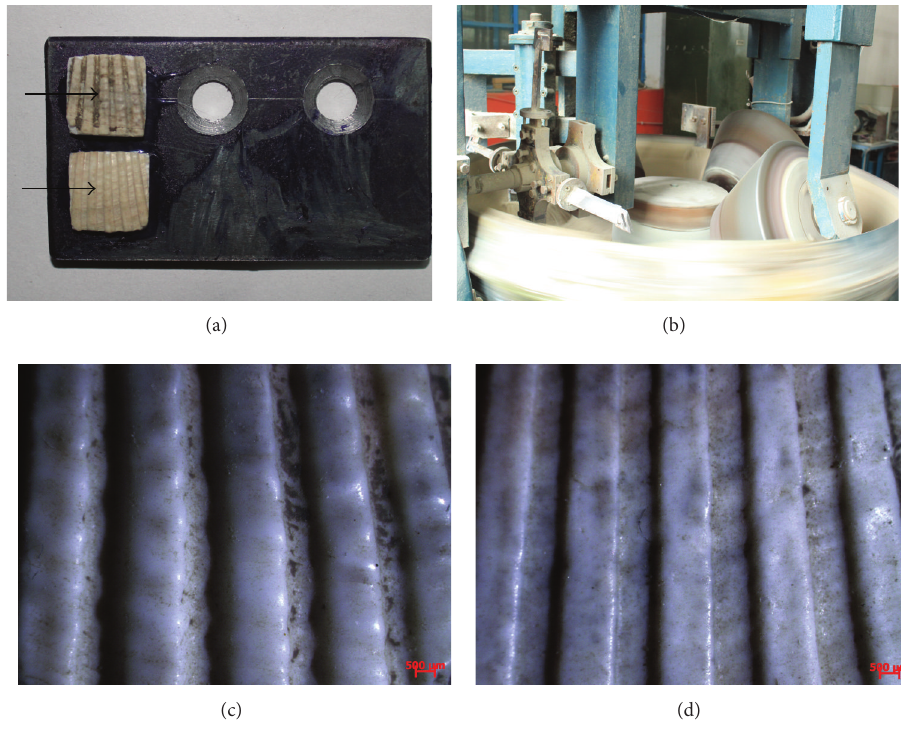
Figure 2: Illustration of the antiwear test equipment and results of two samples: (a) shell examples pasted on the clamp; the arrow indicates the abrasive direction; (b) JMM rotating disc soil abrasive wear testing machine; (c) stereoscopic microscope photo of worn coupled structure; and (d) rib morphology.